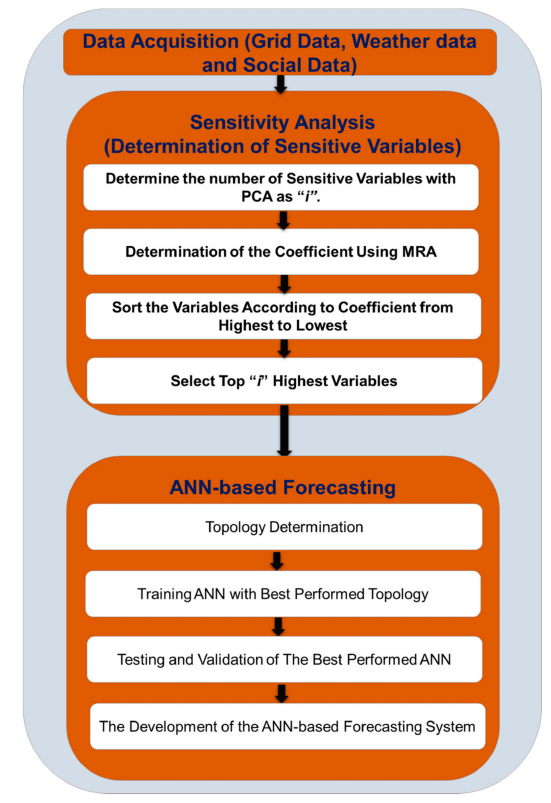
Figure 2. Proposed methodology for the Artificial Neural Network (ANN) based-forecasting